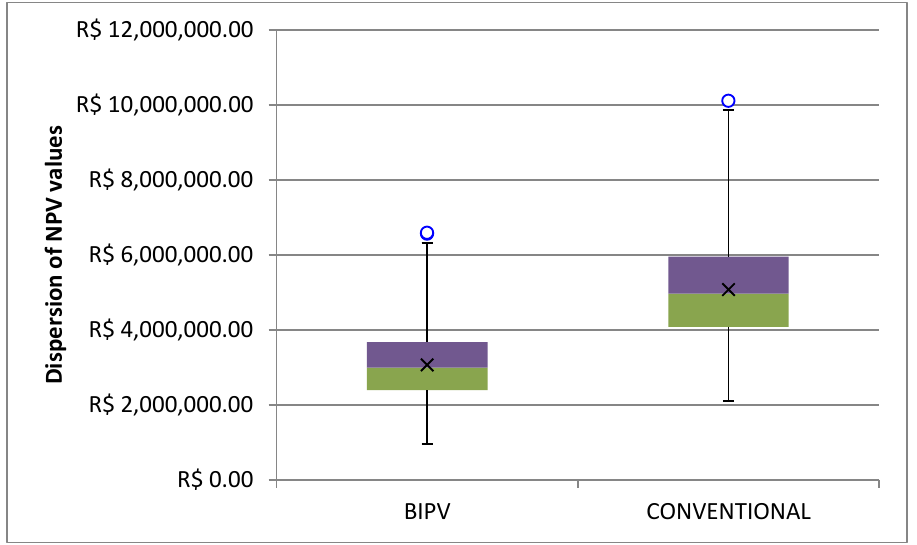
Figure 4. Histograms and cumulative distribution functions of stochastic simulations.